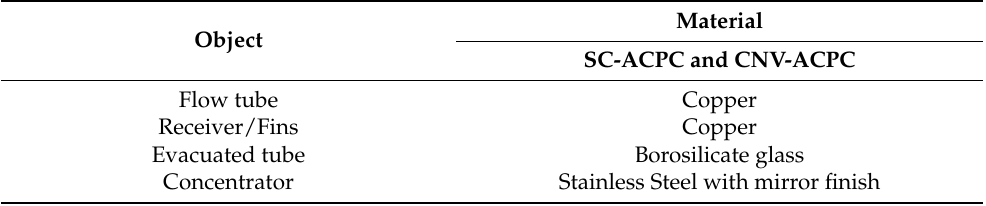
Table 2. CPCs components